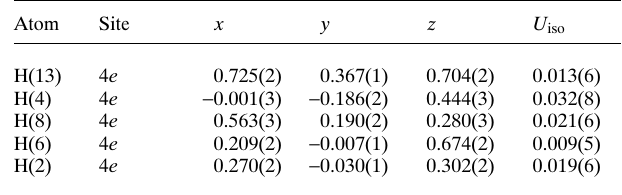
Table 2. Atomic coordinates and displacement parameters (in Å 2 )